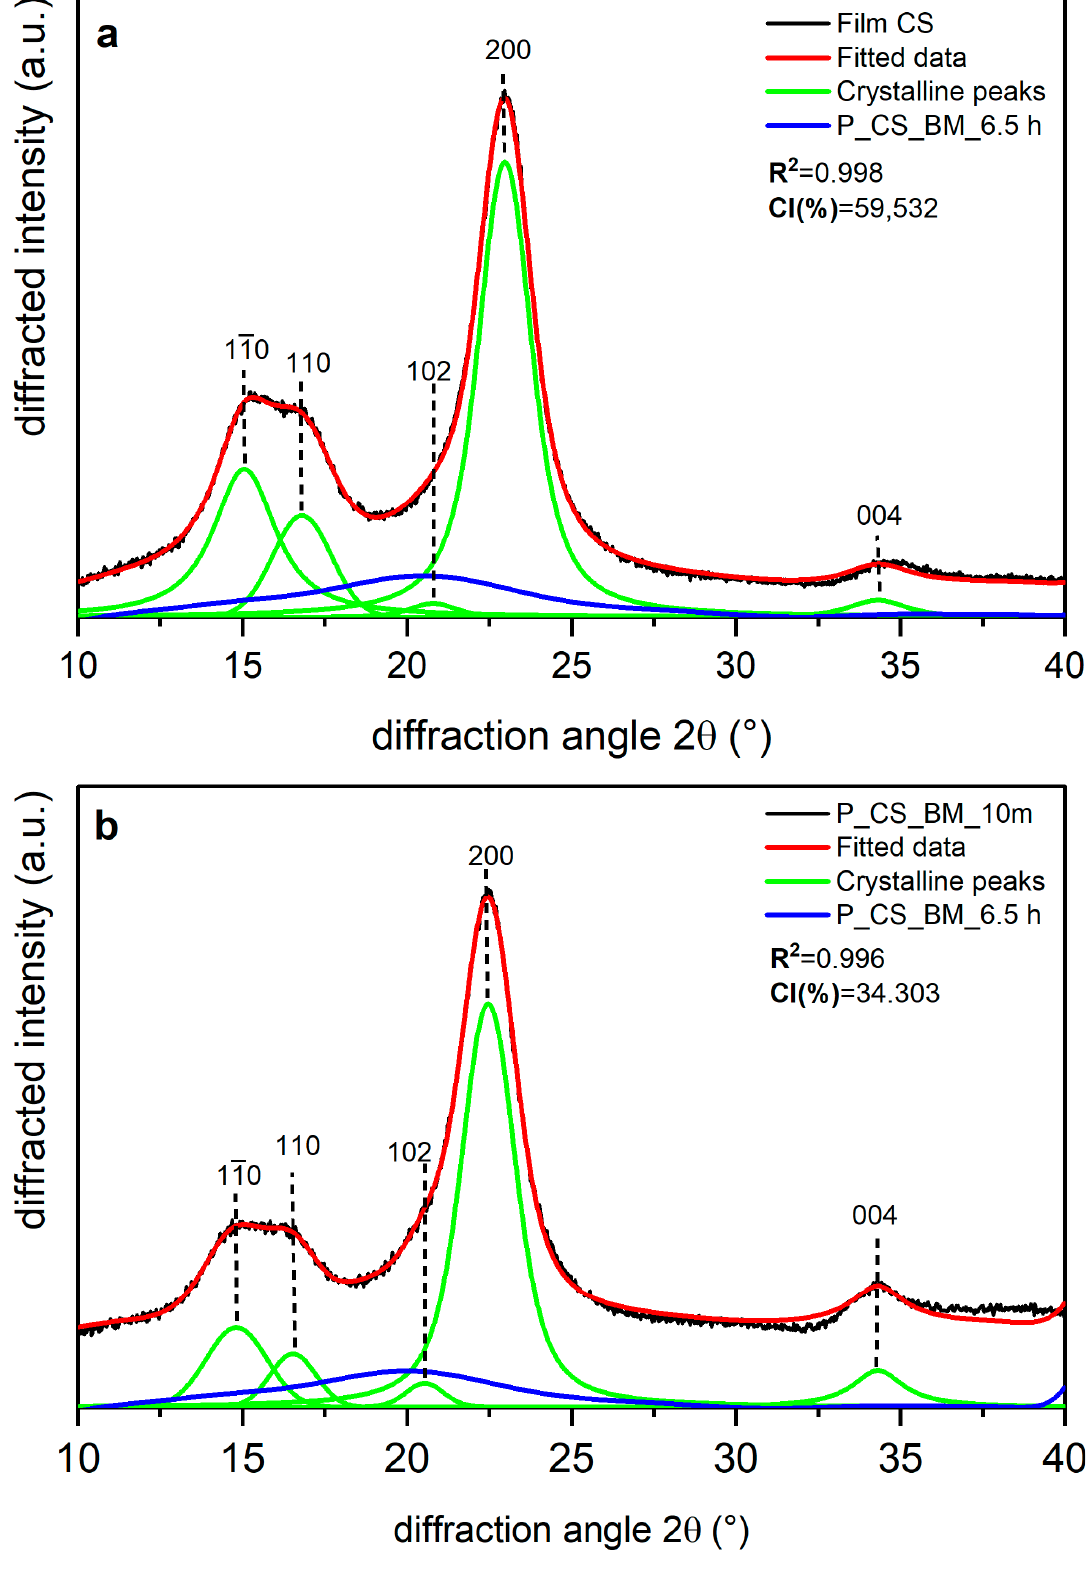
Figure 6. X-ray diffraction spectra recorded from commercial sample cellulose (CS): ( a ) unmilled (film CS), and ( b ) milled for 10 min (P_CS_BM_10 m) and 6.5 h (P_CS_BM_6.5 h). The indexation is that defined in [40].